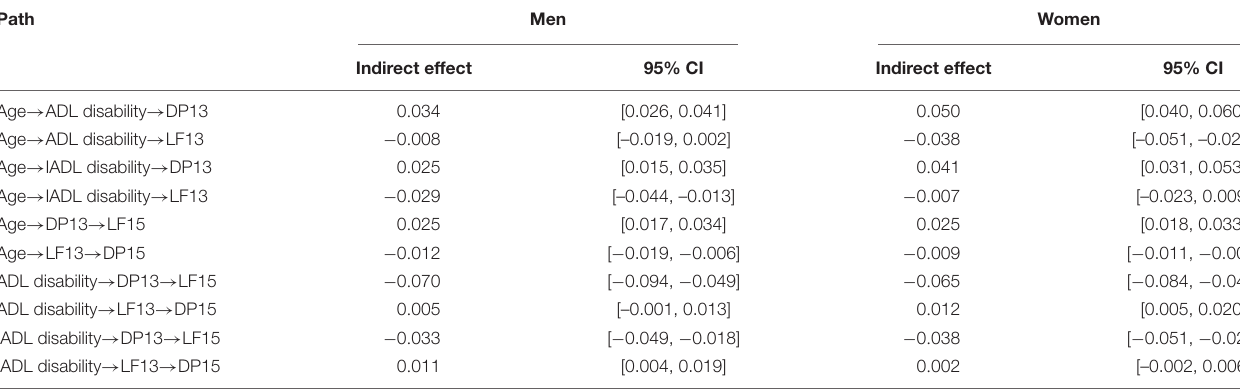
TABLE 5 | Mediating effects in different gender mediating models.